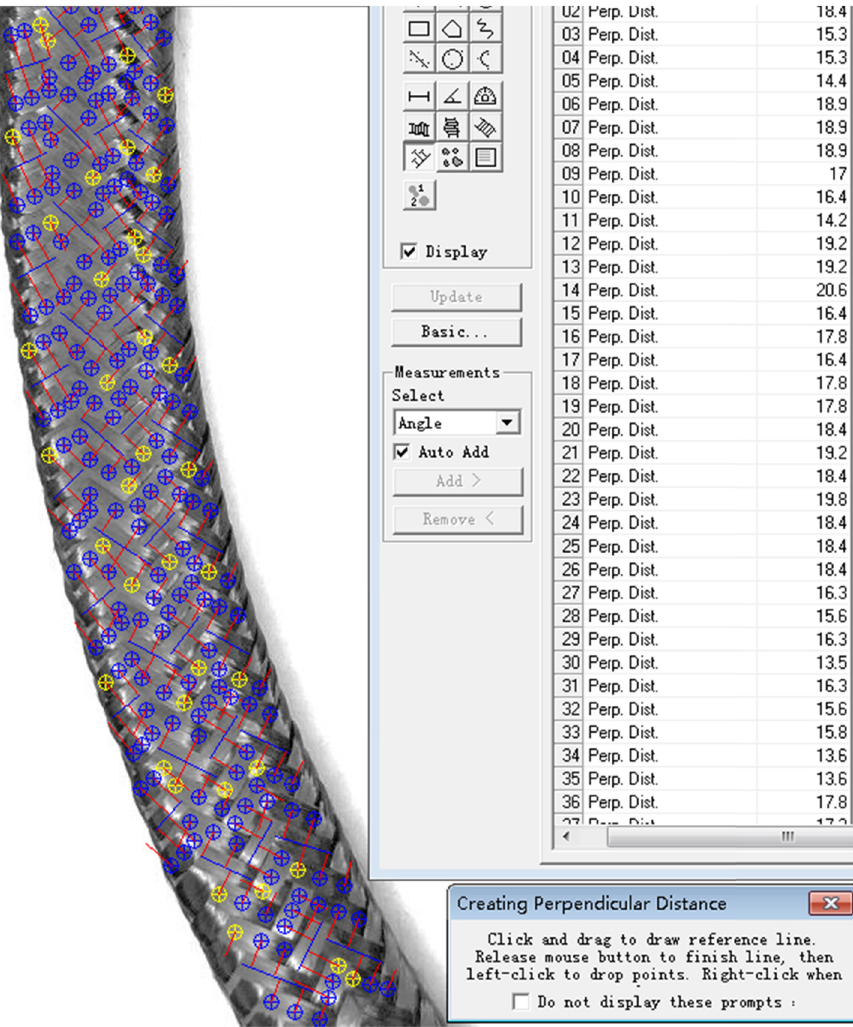
Figure 8: Measurement of yarn spacing.